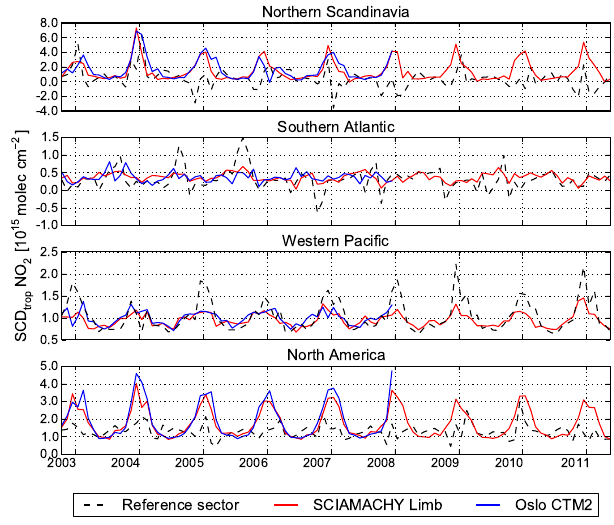
Fig. 19. Time series of monthly mean values of SCD trop NO 2 for the regions labelled above as Northern Scandinavia (60 ◦ N–75 ◦ N, 0 ◦ –40 ◦ E), Southern Atlantic (50 ◦ S–30 ◦ S, 45 ◦ W–15 ◦ E), Western Pacific (25 ◦ N–50 ◦ N, 148 ◦ E– 178 ◦ E), and North America (40 ◦ N–60 ◦ N, 120 ◦ W–90 ◦ W). Three different stratospheric corrections have been used: SCIAMACHY limb measurements (red), Oslo CTM2 simulations (blue, only until 2007), and the referencesectormethod(black).